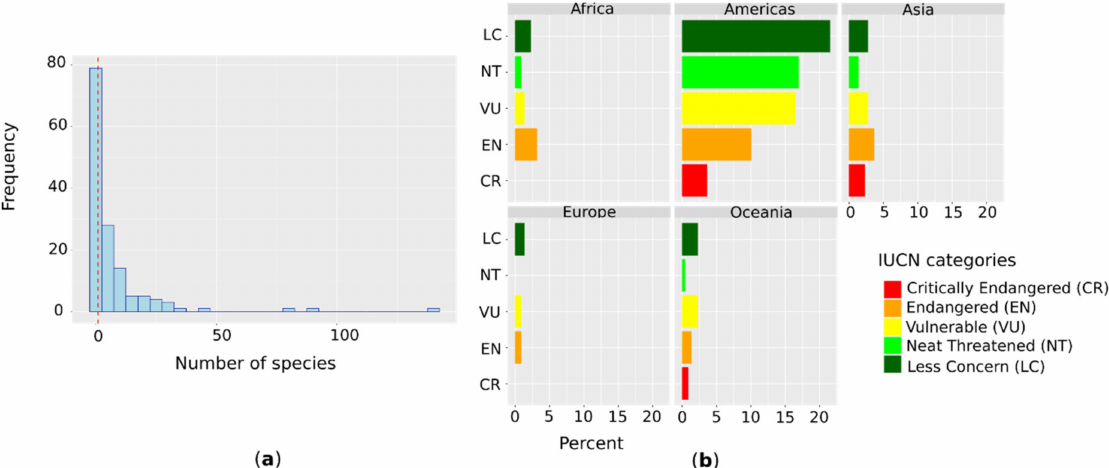
Figure 2. ( a ) Number species reported in published documents on illegal parrot trade. Median value shown as a dotted red line. ( b ) Percentage of species reported as illegally traded for each IUCN conservation status category by